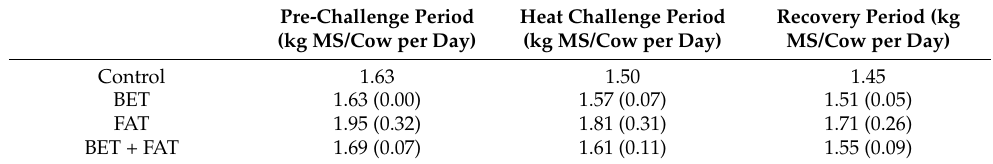
Table 3. Daily mean milk solids production (kg milk solids/cow per day) of cows fed the control, BET, FAT and BET + FAT diets for the pre-challenge, heat challenge and the recovery periods of the experiment. Numerical differences between the control diet and each experimental diet are shown in